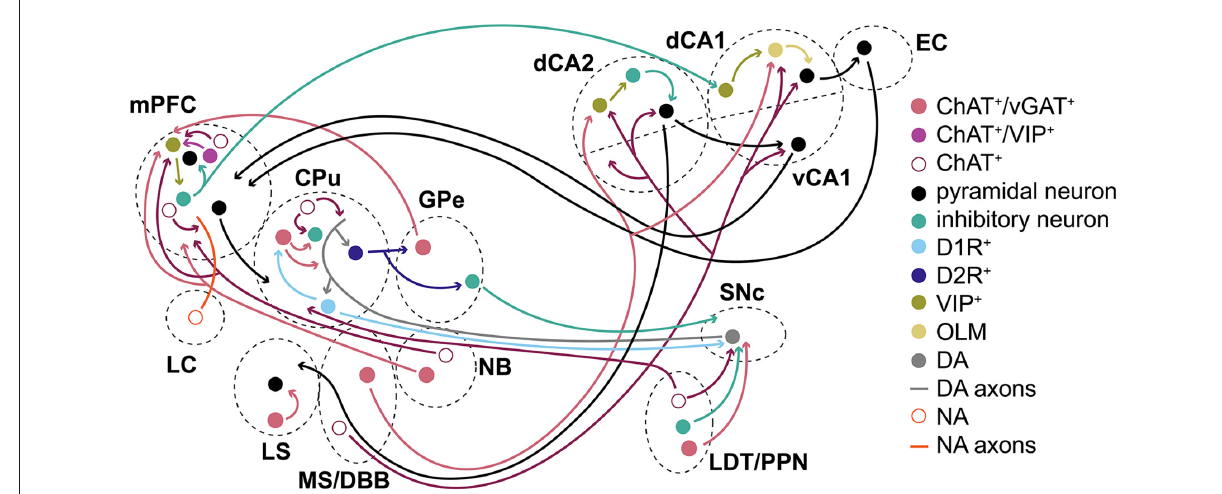
FIGURE6 Summary/simplified model. Simplified model of how ACh/GABA co-transmission is embedded in the circuitry of cortical and subcortical structures. ACh/GABA projections from the basal forebrain (MS/DBB and NB) form synapses in the hippocampus and mPFC, respectively. The hippocampal outputs vary based on dorsal or ventral location of the neurons to mPFC or EC, among others. Basal ganglia structures such as CPu or GPe contain either local ACh/GABA interneurons, receive inputs from LDT/PPN, or project to the mPFC. The mPFC contains local ACh/GABA interneurons and receives noradrenergic (NA) inputs from the locus coeruleus (LC). SNc DA neurons receive ACh/GABA projections from